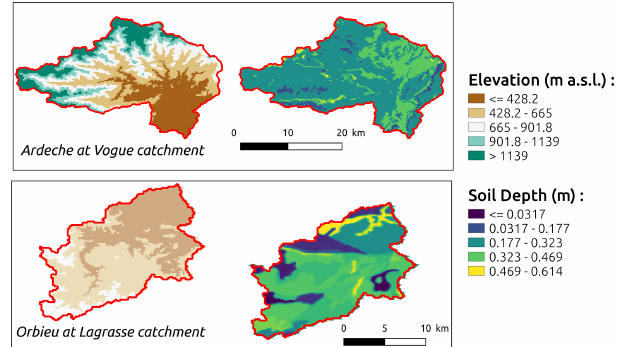
Figure 3. The IGN-25m DEM and soil depth maps from the INRA soil database used for MARINE parametrization for the two studied